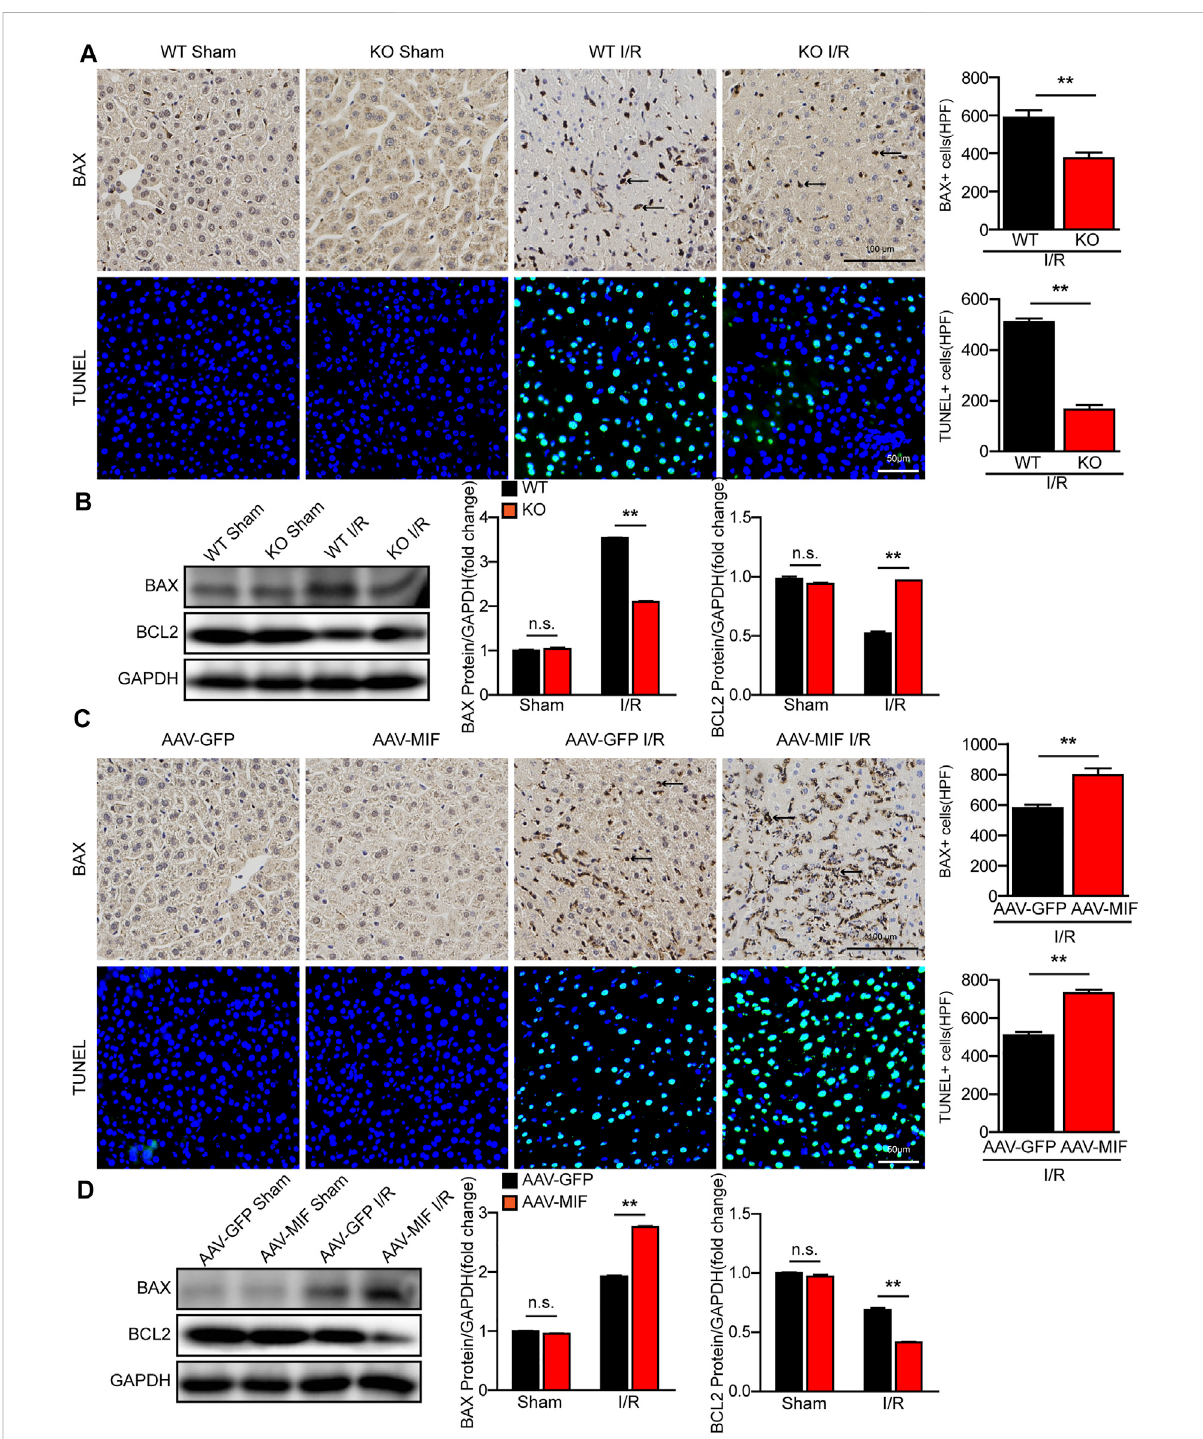
FIGURE 4 MIF deletion suppresses apoptosis in hepatic I/R injury. (A) IHC staining of BAX and TUNEL staining in liver sections from WT and MIF-KO mice after hepatic I/R surgery ( n = 4/group). Scale bar, 100 μ m of IHC staining and 50 μ m of TUNEL staining respectively. Marked by black arrow. (B) Western blot analysis of apoptosis-related molecules (BAX, BCL2 and C-Caspase-3) protein levels in the liver of WT and MIF-KO mice at 6 h after hepaticI/Rsurgery.GAPDHservedasaloadingcontrol( n =3/group). (C) IHCstainingofBAXandTUNELstaininginliversectionsfromAAV-GFP or AAV-MIF mice after hepatic I/R injury ( n = 4/group). Scale bar, 100 μ m of IHC staining and 50 μ m of TUNEL staining respectively. Marked by black arrow. (D) Westernblotanalysisofapoptosis-relatedmolecules(BAX,BCL2andC-Caspase-3)proteinlevelsintheliverofAAV-GFPorAAV-MIFmice after hepatic I/R injury. GAPDH served as a loading control ( n = 3/group). All data are shown as the mean ± SD. Levels of statistical signi fi cance are indicatedas** p < 0.01.Forstatisticalanalysis,one-wayANOVAwithBonferroni ’ sposthocanalysisorTamhane ’ sT2posthocanalysisandtwo-tailed Student t test were